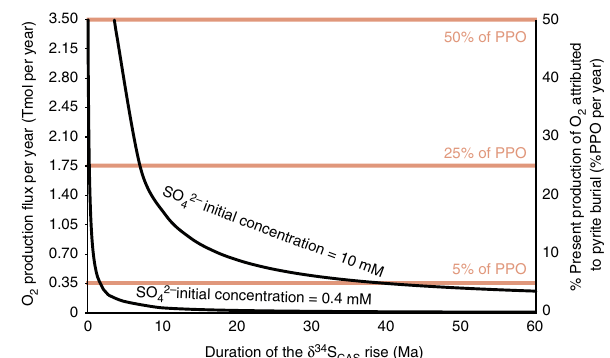
Figure 6 | O 2 fluxes versus duration of the sulfur isotopic excursion. O 2 fluxes produced by a 50% distillation of the oceanic sulfate reservoir by sulfate-reduction and pyrite burial as a function of the duration of the sulfur isotopic excursion. For the bottom curve the starting concentration of sulfate was of 0.4mM, for the top one it was of 10mM. The y axis to the right corresponds to the proportion of O 2 produced compared with the present production of O 2 attributed to pyrite burial per year (PPO/yr), estimated at 7Tmol per year by Holland et al.